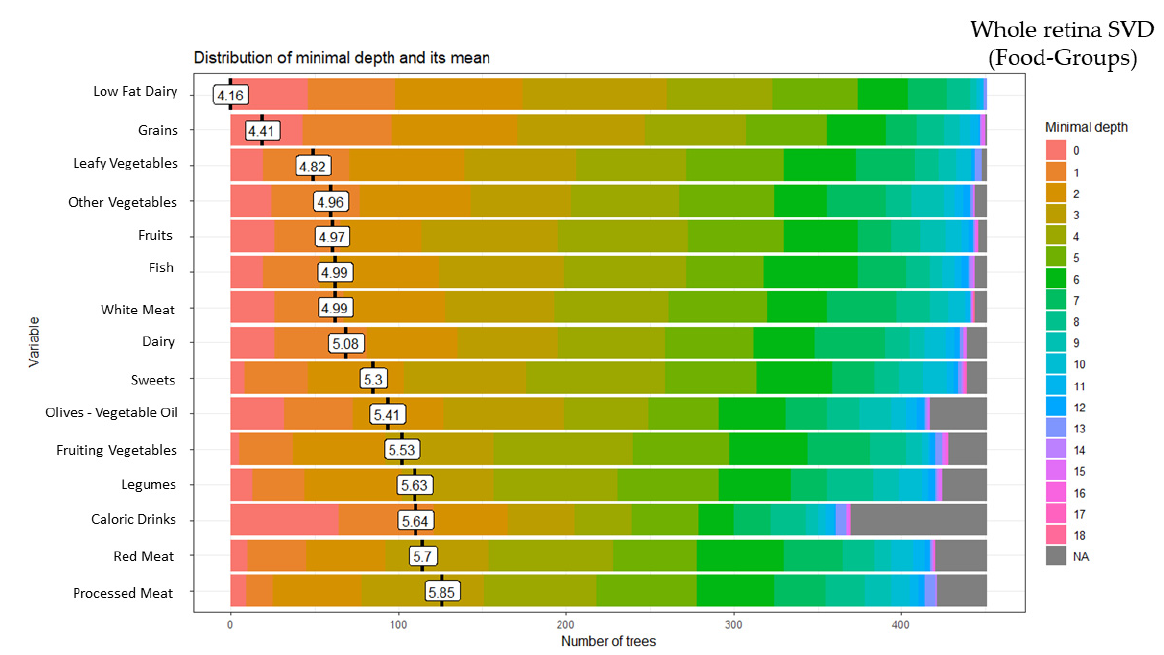
Figure 3. Random forest food group and whole retina superficial vessel density (SVD).